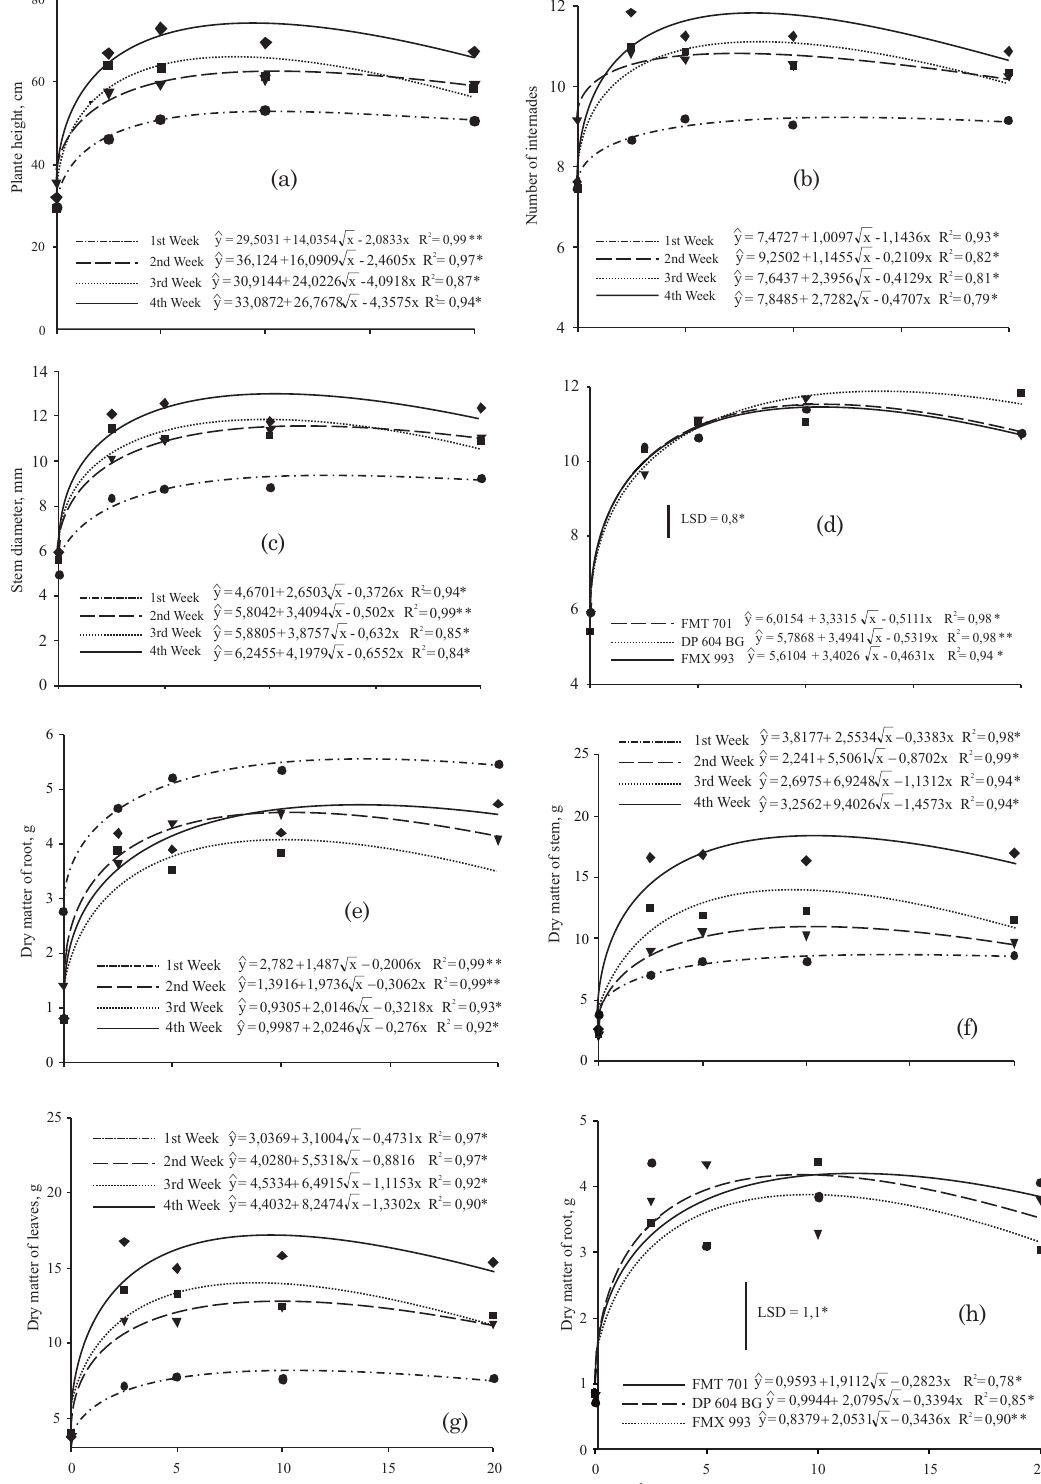
Figure 1. Plant height (a), number of internodes (b) and stem diameter (c) of cotton plants, averaged over three cultivars, as affected by solution B and weeks after the first square stage (B1); and stem diameter of three cotton cultivars at the second week after B1 (d), as affected by B rates in the nutrient solution. LSD = Least Significant Difference; * and ** significant at 5 and 1 %, respectively. (cid:122)(cid:122)(cid:122)(cid:122)(cid:122) , , , = 1 st , 2 nd , 3 rd and 4 th week, respectively. (cid:122)(cid:122)(cid:122)(cid:122)(cid:122) , , = FMT 701, DP 604BG and FMX 993,